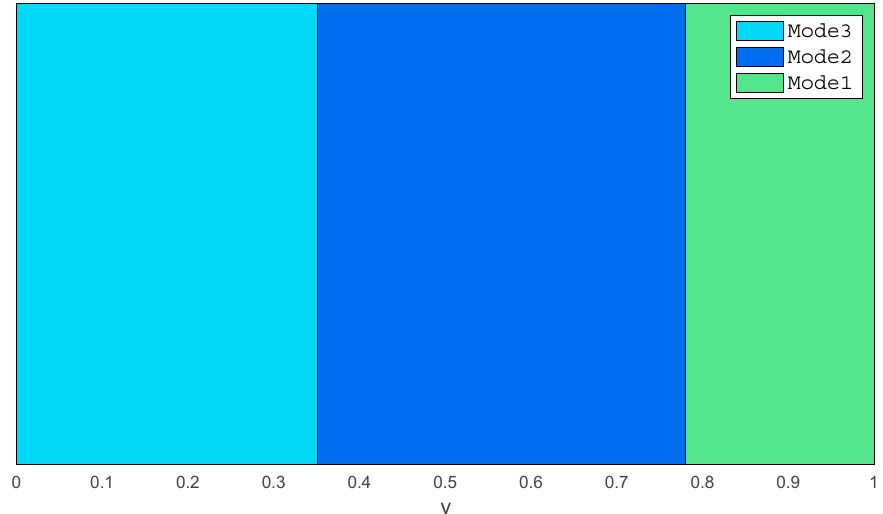
Figure 3. Boundary condition of operating space with gap-metric method.